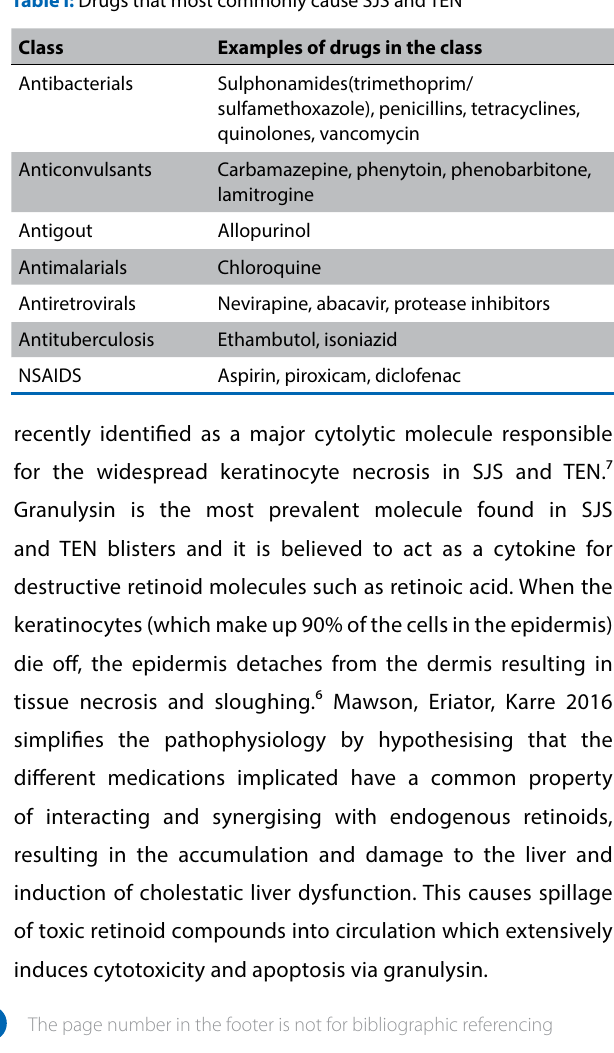
Table l: Drugs that most commonly cause SJS and